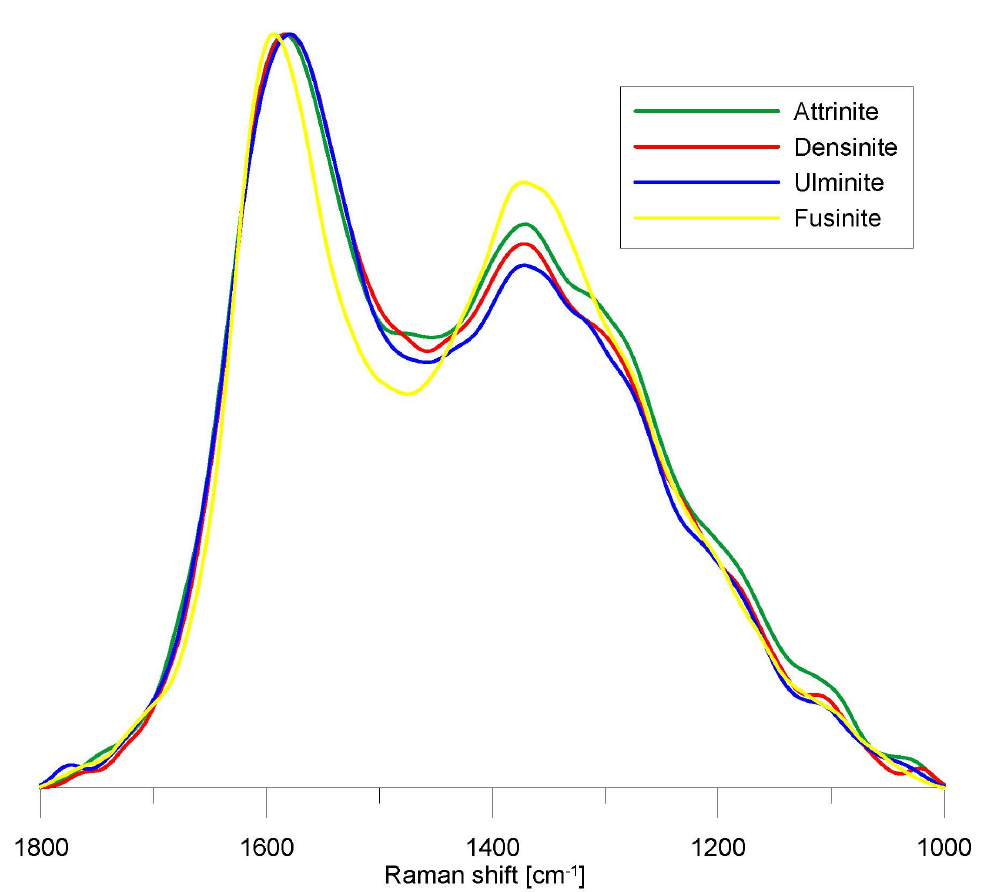
Figure 2. Representative micro-Raman spectra of the investigated macerals.